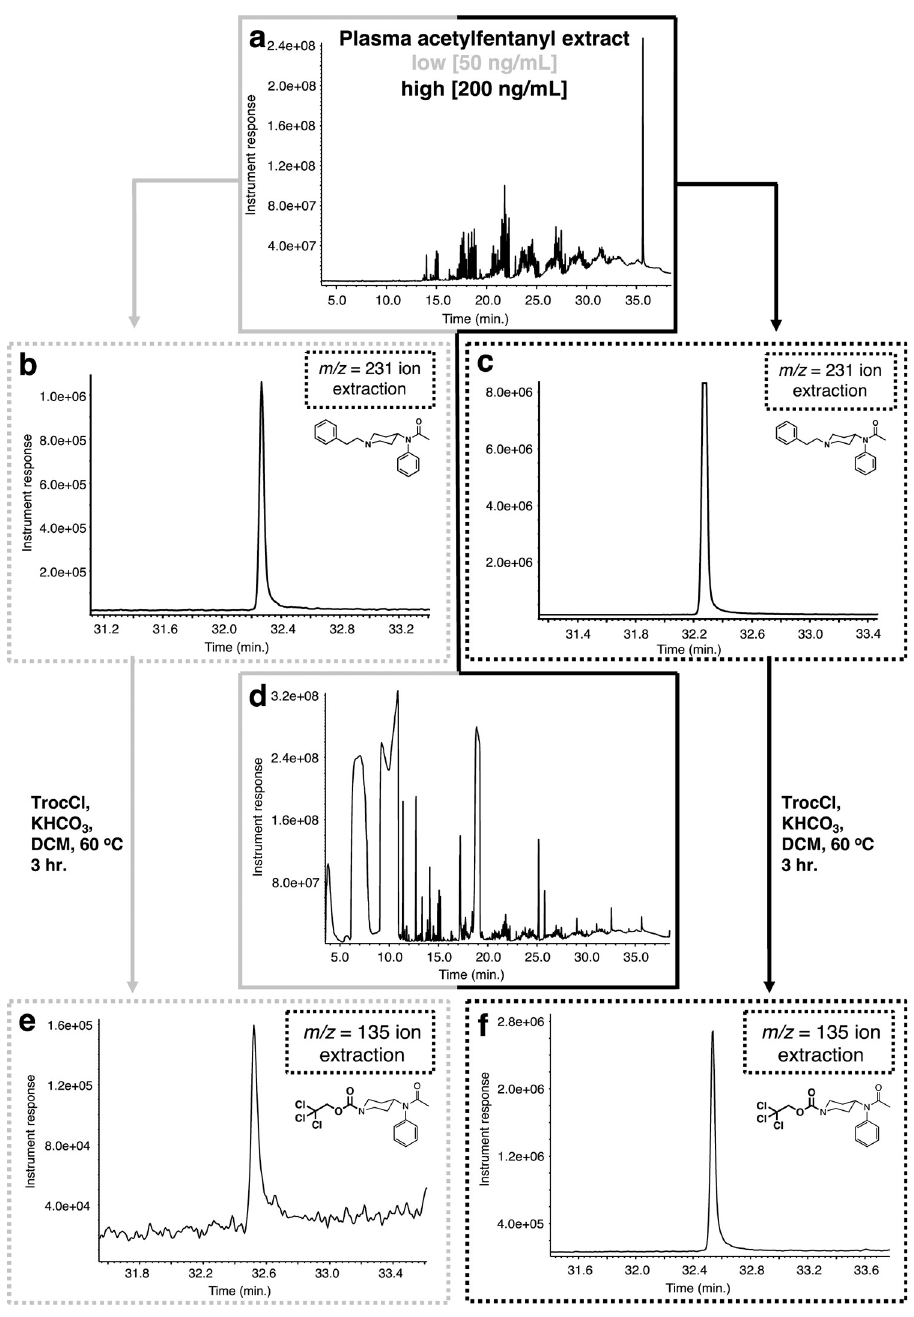
Fig 7. Extraction and reaction of acetylfentanyl with Troc-Cl when spiked in plasma. (a) GC chromatogram of extracted plasma sample; (b) extracted ion (m/z = 231) chromatogram for acetylfentanyl (rt = 32.3 min.) for low concentration plasma spike (50 ng/mL); (c) extracted ion (m/z = 231) chromatogram for fentanyl for high concentration plasma spike (200 ng/mL); (d) GC chromatogram of the reaction between extracted plasma sample and Troc-Cl; (e) extracted ion (m/z = 135) chromatogram for Troc-norfentanyl for the low concentration plasma sample (rt = 32.6 min.); (f) extracted ion (m/z = 135) chromatogram for Troc-norfentanyl for the high concentration spiked plasma